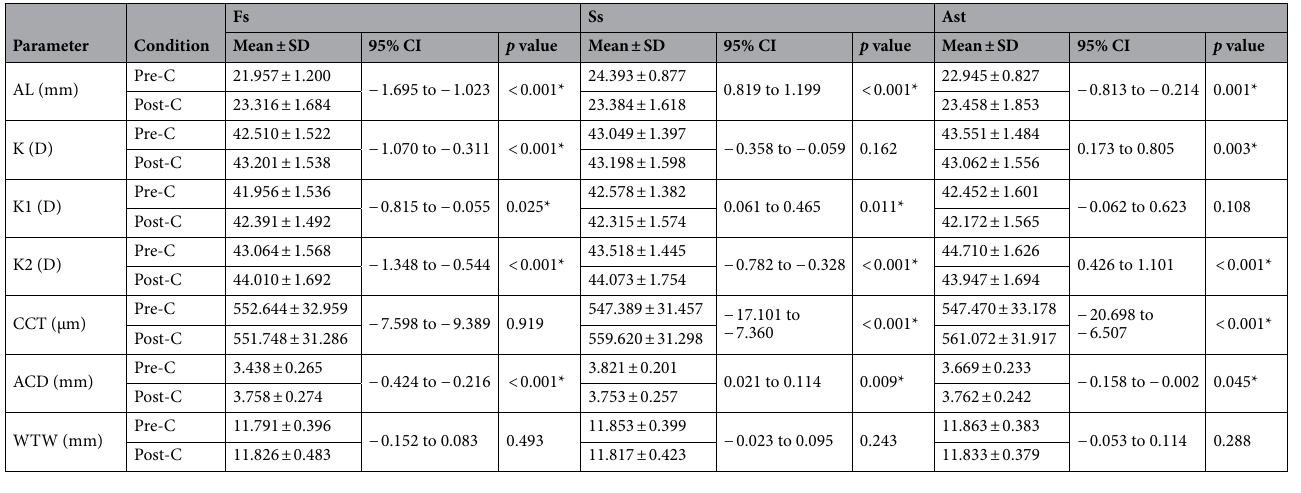
Table 2. Statistical analysis of the mean, SD, and 95% CI of ocular biological characteristics of the subjects pre- and postcycloplegia in the Fs, Ss and Ast groups. AL axial length; K mean keratometry, K1 flat keratometry, K2 steep keratometry, CCT central corneal thickness; ACD anterior chamber depth; WTW white-to-white distance; D dioptre; C cycloplegia; SD standard deviation; CI confidence interval. * p < 0.05 was considered statistically significant.